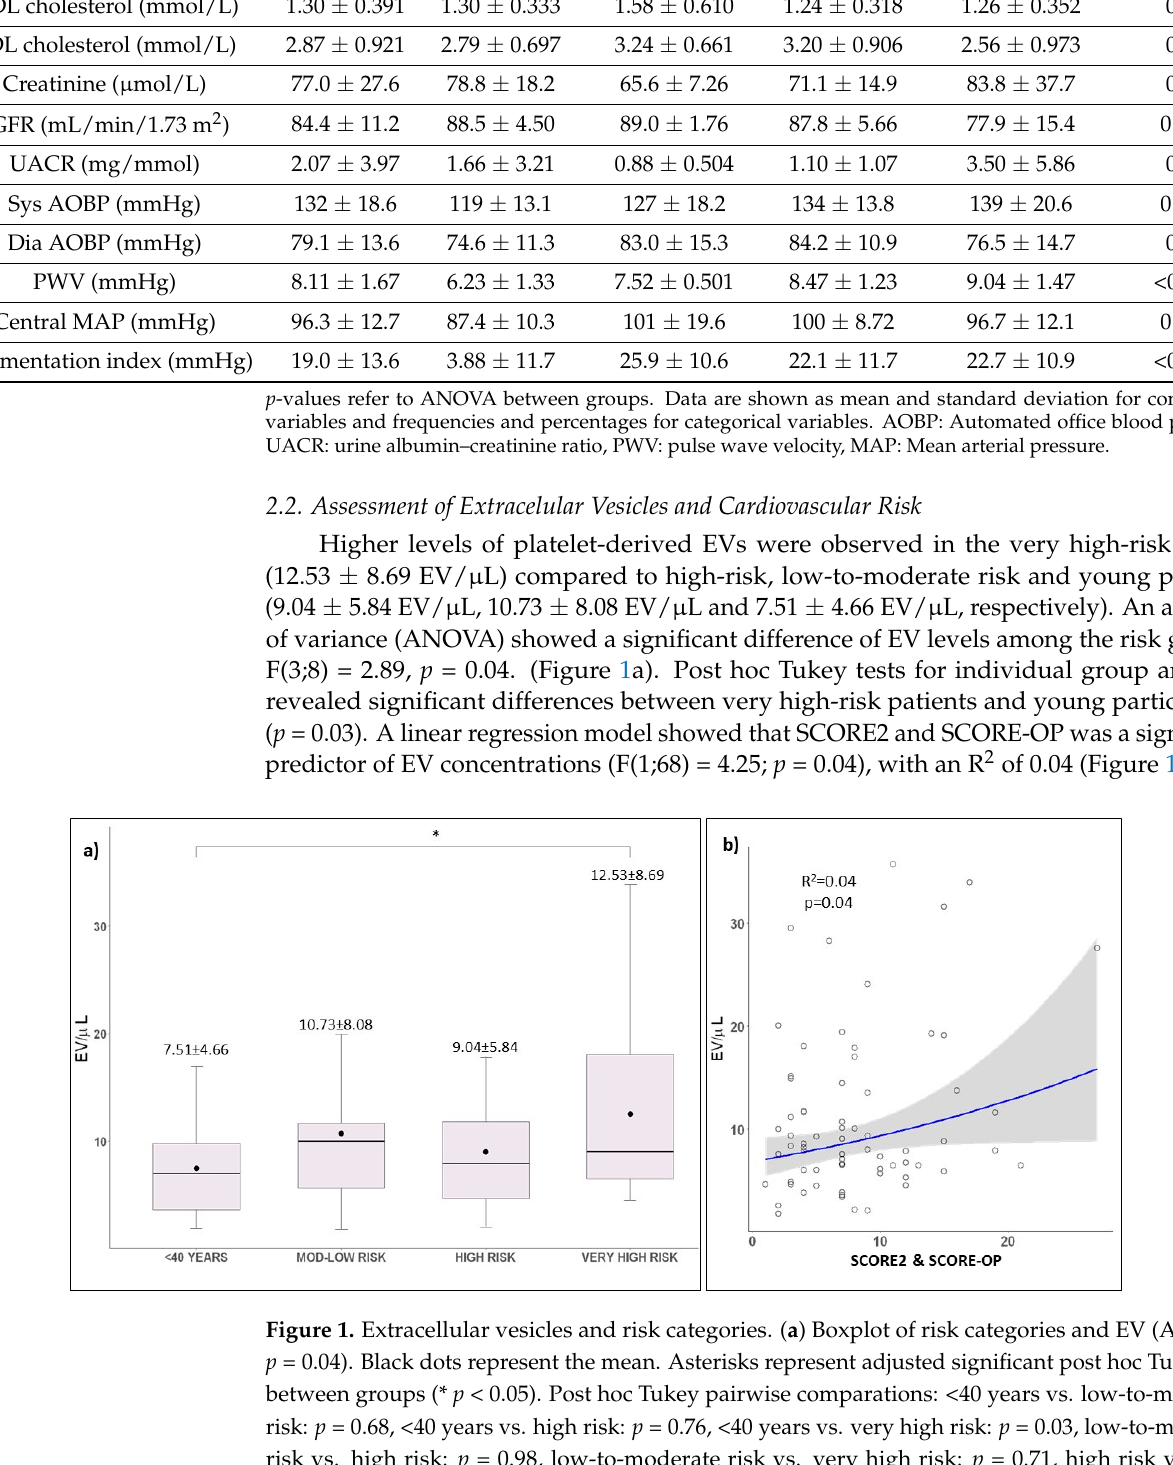
Figure 2. Extracellular vesicles and macrovascular damage. Regression model of extracellular vesi- cles and PWV ( p = 0.01). Blue line represents regression line of best fit. The grey bands around the line represent 95% confidence intervals.